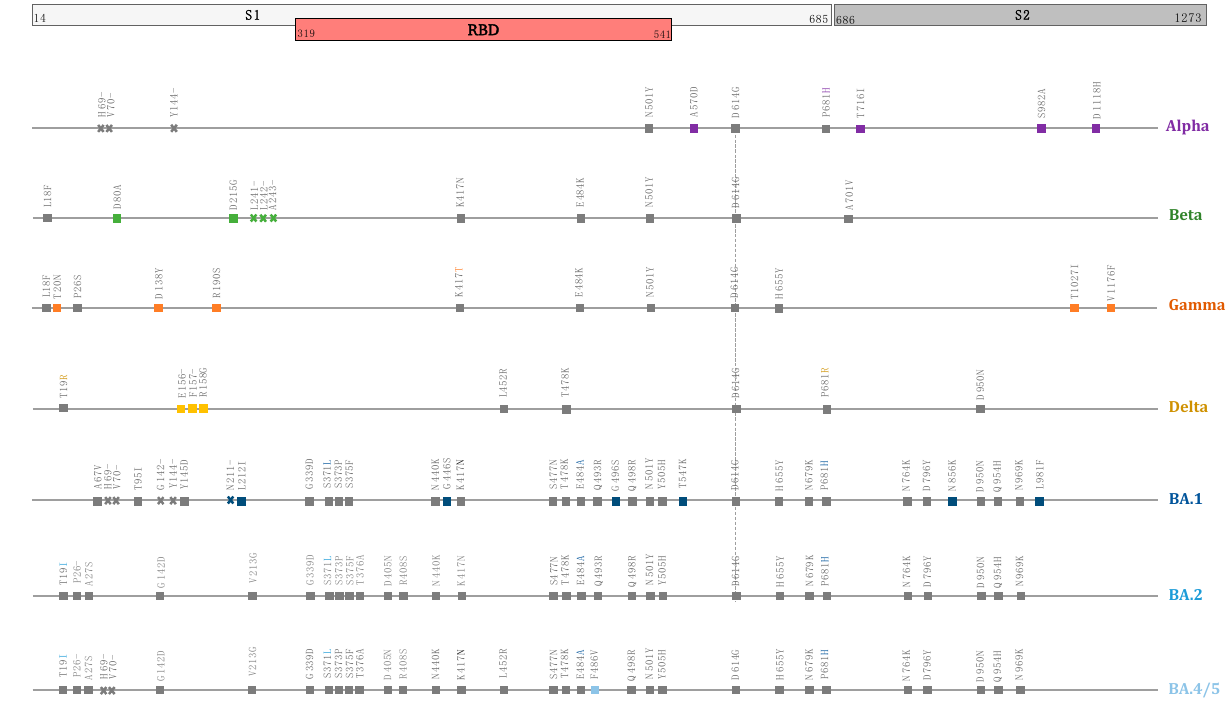
Figure 2. Signature mutations in different SARS-CoV-2 circulating VOCs. Lineage-specific mutations are colored, and shared mutation are indicated in